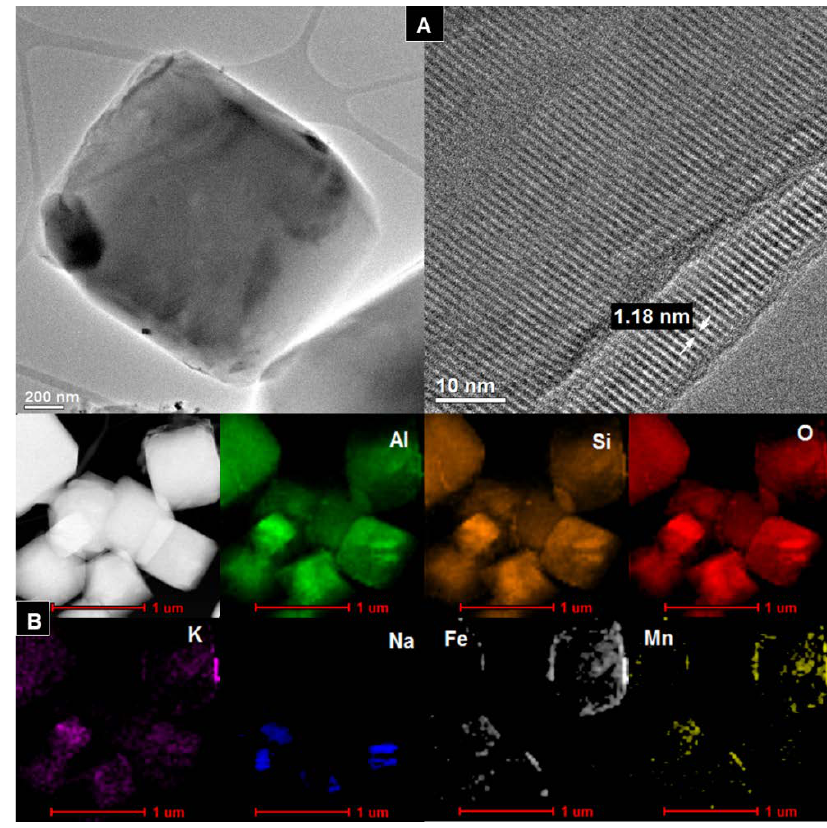
Figure 7. ( A ) HR/TEM images and ( B ) STEM-EDS analysis of Na-A-TS sample. Figure 6. ( A ) HR/TEM images and ( B ) STEM-EDS analysis of Na-A-LS